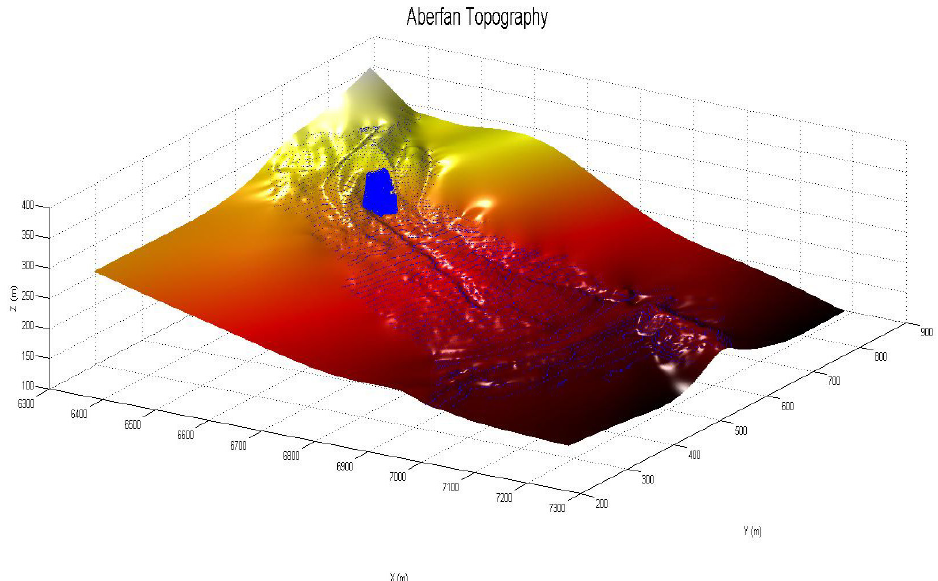
Figure 9. Aberfan topography and SPH nodes at the beginning of the simulation. Table 2. Parameters used for the numerical simulation.